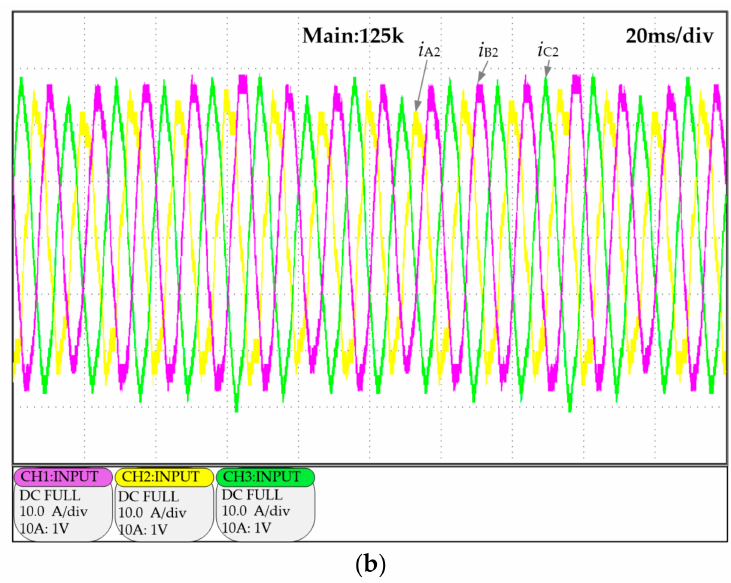
Figure 19. The current waveforms of the second set of windings: ( a ) Three phase currents under normal conditions; ( b ) Three phase currents under faulty conditions.